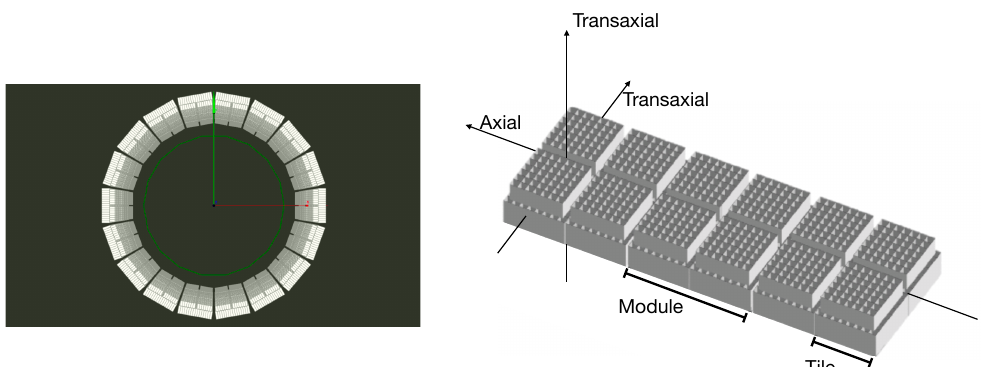
Figure 1. ( Left ) Simulated view of TRIMAGE full detector ring. ( Right ) Schematic view of a sector. Each tile features two segmented LYSO:Ce crystal layers. The top layer consists of 7 × 7 crystals of 3.3 × 3.3 × 8 mm 3 , while the bottom layer, centered with respect to the top layer, consists of 8 × 8 crystals of 3.3 × 3.3 × 12 mm 3 . The crystals in both layers have a pitch of 3.4 mm and both layers are staggered by a half-pitch. This configuration permits both reducing the depth of interaction (DOI) uncertainty and achieving a better sampling of the FOV with respect to a single layer with the same pixel pitch. A black thin separator is placed between adjacent bottom layers to reduce the optical crosstalk between tiles. An enhanced specular reflector (3M ESR) is placed on the lateral sides of each crystal, while the open face of the top layer is covered with a white Teflon tape. There are 216 tiles in the whole system, corresponding to 24,408 (216 × 113) crystals. The AFOV and TFOV are, respectively, 164 and 260 mm. The crystals in the bottom layer are directly coupled to 64 near ultraviolet SiPMs that are arranged in two matrices, specifically designed and manufactured by AdvanSiD s.r.l., Trento, Italy. Each element has a size of 3 × 3 mm 2 and a pitch of 3.4 mm in order to match the scintillator pitch. Each SiPM has 5520 micro-cells, 40 µ m side with a 60% fill-factor. The 64 signals from a tile are read out by a 64-channel TRIROC ASIC [38]. Four TRIROC ASICs are hosted on a front-end board which we refer to as the ASIC board. The ASIC board can read out all 256 output signals from a module and the complete PET front-end data acquisition system is composed by 54 ASIC boards. The digital part of the ASIC manages the conversion and the data transmission to the front- end FPGA-based board (called the TX board), which computes the timestamp associated to each triggered SiPM and transmits the acquired data to the back-end for coincidence processing [39]. A data packet corresponds to every single event that is stored in FPGA for online processing: here, the interaction position, the final timestamp and the whole energy released are computed. The back-end system is composed of a motherboard (MB) and 9 receiver boards (called RX boards). Each RX board receives data from two TX boards. A schematic diagram of the acquisition pipeline is shown in Figure 2, while a more in-depth review of the data acquisition system can be found in